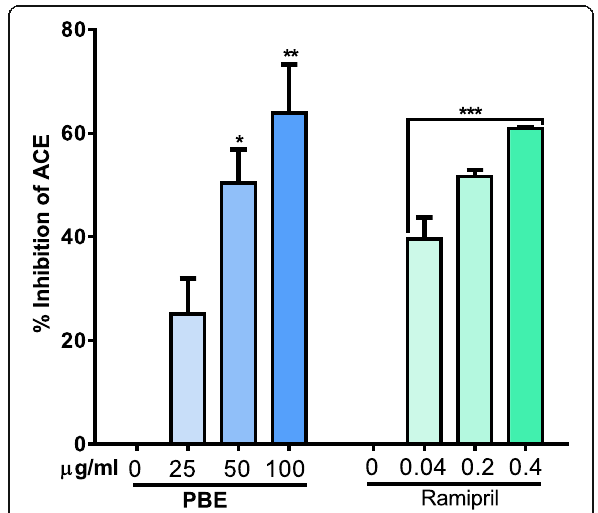
Fig. 3 Inhibition of angiotensin-1-converting enzyme by P. biglobosa leaf extract in vitro. Results are mean ± SEM of three parallel measurements. *** P < 0.001 vs 0 μ